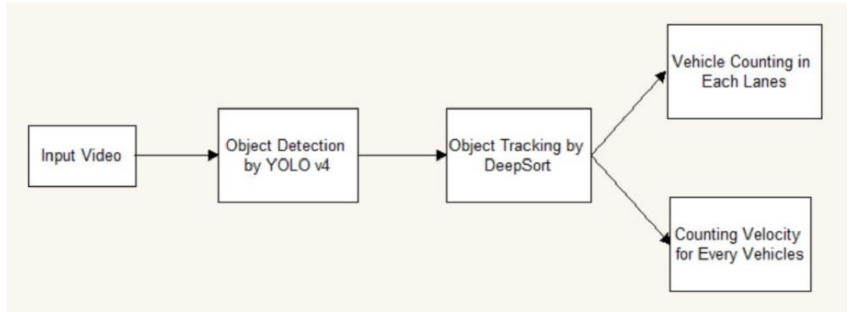
Figure 3. Flow chart of the whole